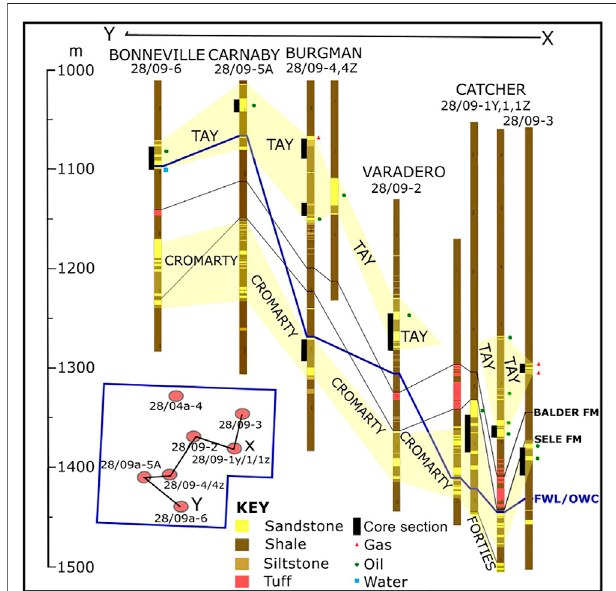
FIGURE 2 | Well correlation diagram highlighting the depth relationship of the reservoir sands of the CAD region. The hydrocarbon fi lled sands (gas- saturated and oil-saturated) together with the oil-water-contacts/free-water- levels are shown. The core sections obtained during drilling are also